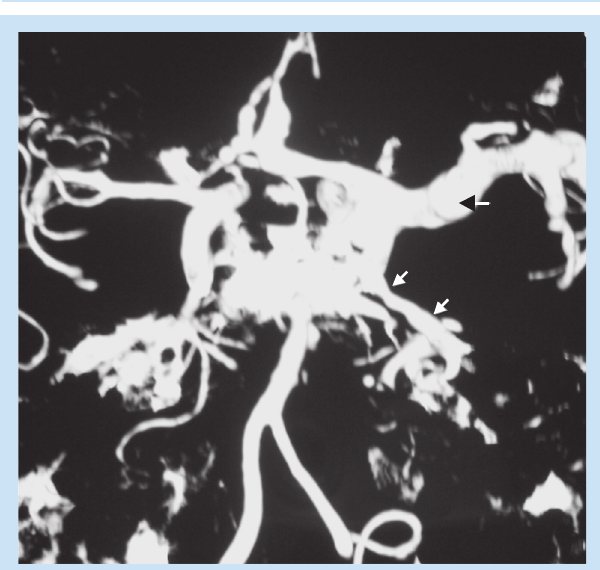
FIG. 7. CTA of the circle of Willis, showing vasculopathy with alternating areas of stenosis and dilatation